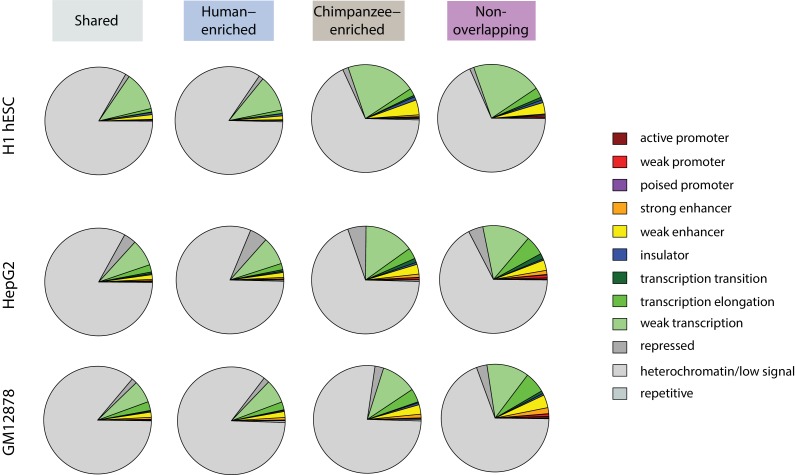
TEs preferentially silenced by H3K9me3 in human, are depleted for regions of active chromatin in human, relative to TEs preferentially silenced in chimpanzee.Orthologous TEs categorized by H3K9me3 silencing category that overlap chromatin states as determined by the ChromHMM algorithm in the H1 hESC line, HepG2 liver cancer cell line, and GM12878 lymphoblastoid cell line.